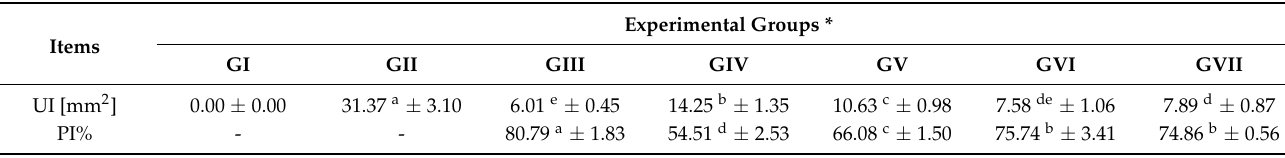
UI: Ulcer index, PI%: Percentage of protection index, * GI: negative control, GII: positive ulcer control; GIII: ulcer+ SP; GIV: Ulcer + KF; GV: ulcer + KP; GVI: ulcer + SFP; GVII: ulcer + Lansoprazole (references group), a–e : values with the same superscript letter in the same raw are not significantly different at p ≤